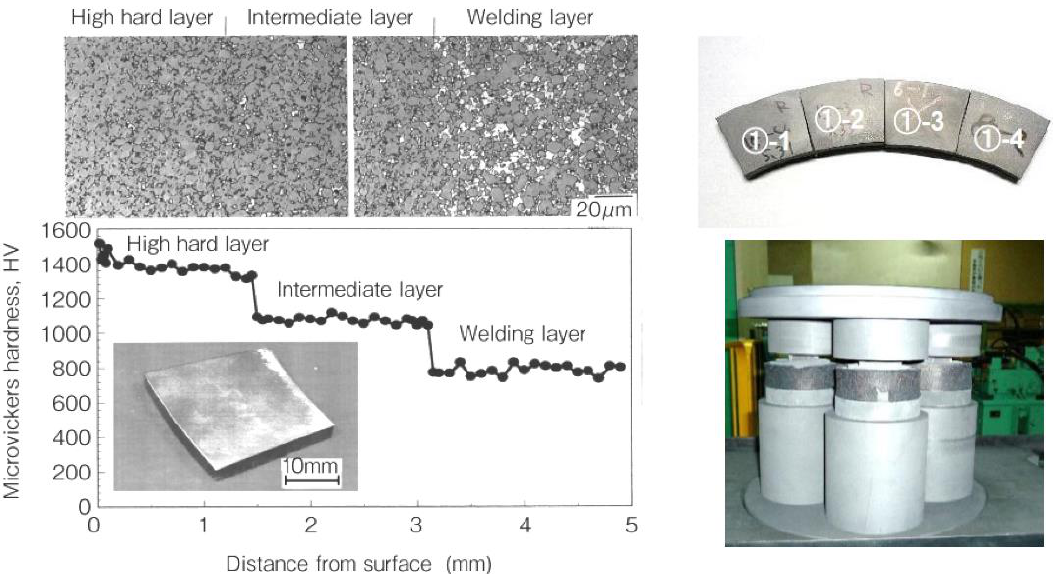
Figure 47. Optical microphotograph and Vickers hardness distribution behavior of weldable WC/Ni FGM tile and simultaneous 4-multiple sintering method.